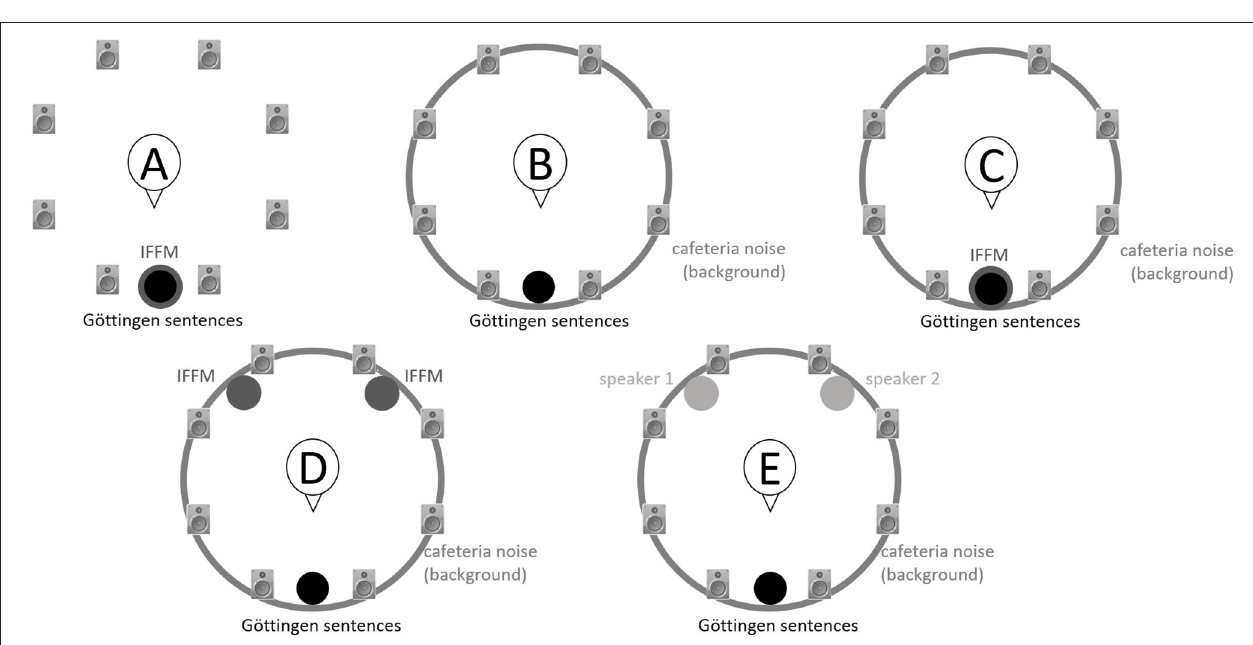
FIGURE 2 | Schematic overview of the five listening conditions for which SRT measurements were conducted to examine speech recognition in a realistic cafeteria situation (B) and the influence of listening in the dips ( A vs. C ), spatial separation ( C vs. D ), and informational masking ( D vs. E ).